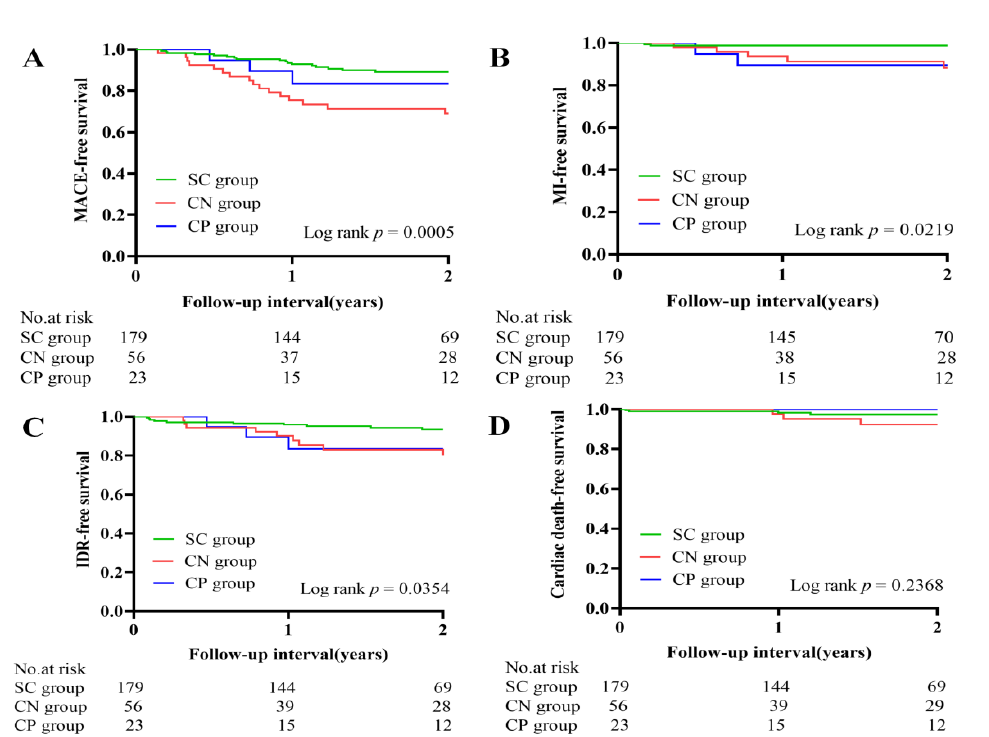
Table 5. Univariate and multivariate Cox proportional hazards model for predictors of MACE. Univariate Analysis